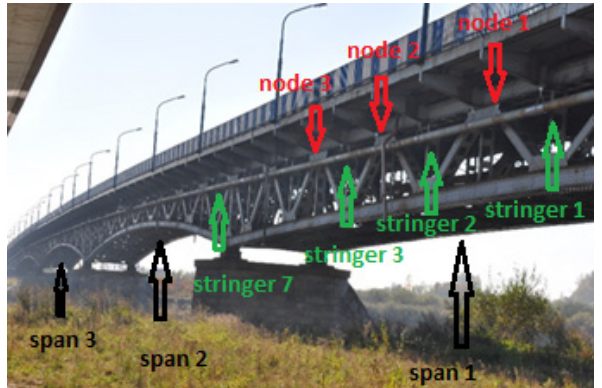
Figure 1. Side view of three bridge spans subjected to tests.